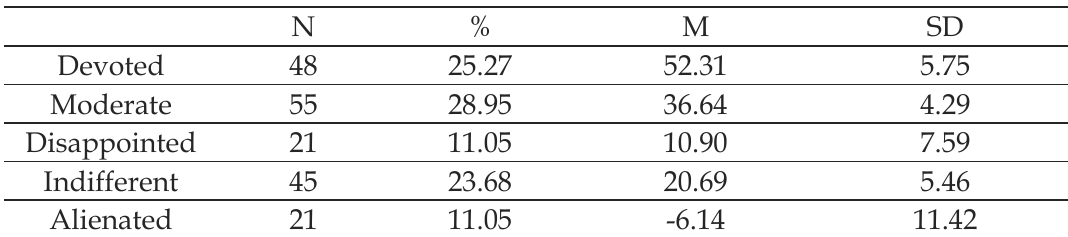
Table 1. Types of civi (cid:543) identity (N=190) Types of civi (cid:543) identity Integral indicator of civic identity N % M SD Devoted 48 25.27 52.31 5.75 Moderate 55 28.95 36.64 4.29 Disappointed 21 11.05 10.90 7.59 Indifferent 45 23.68 20.69 5.46 Alienated 21 11.05 -6.14